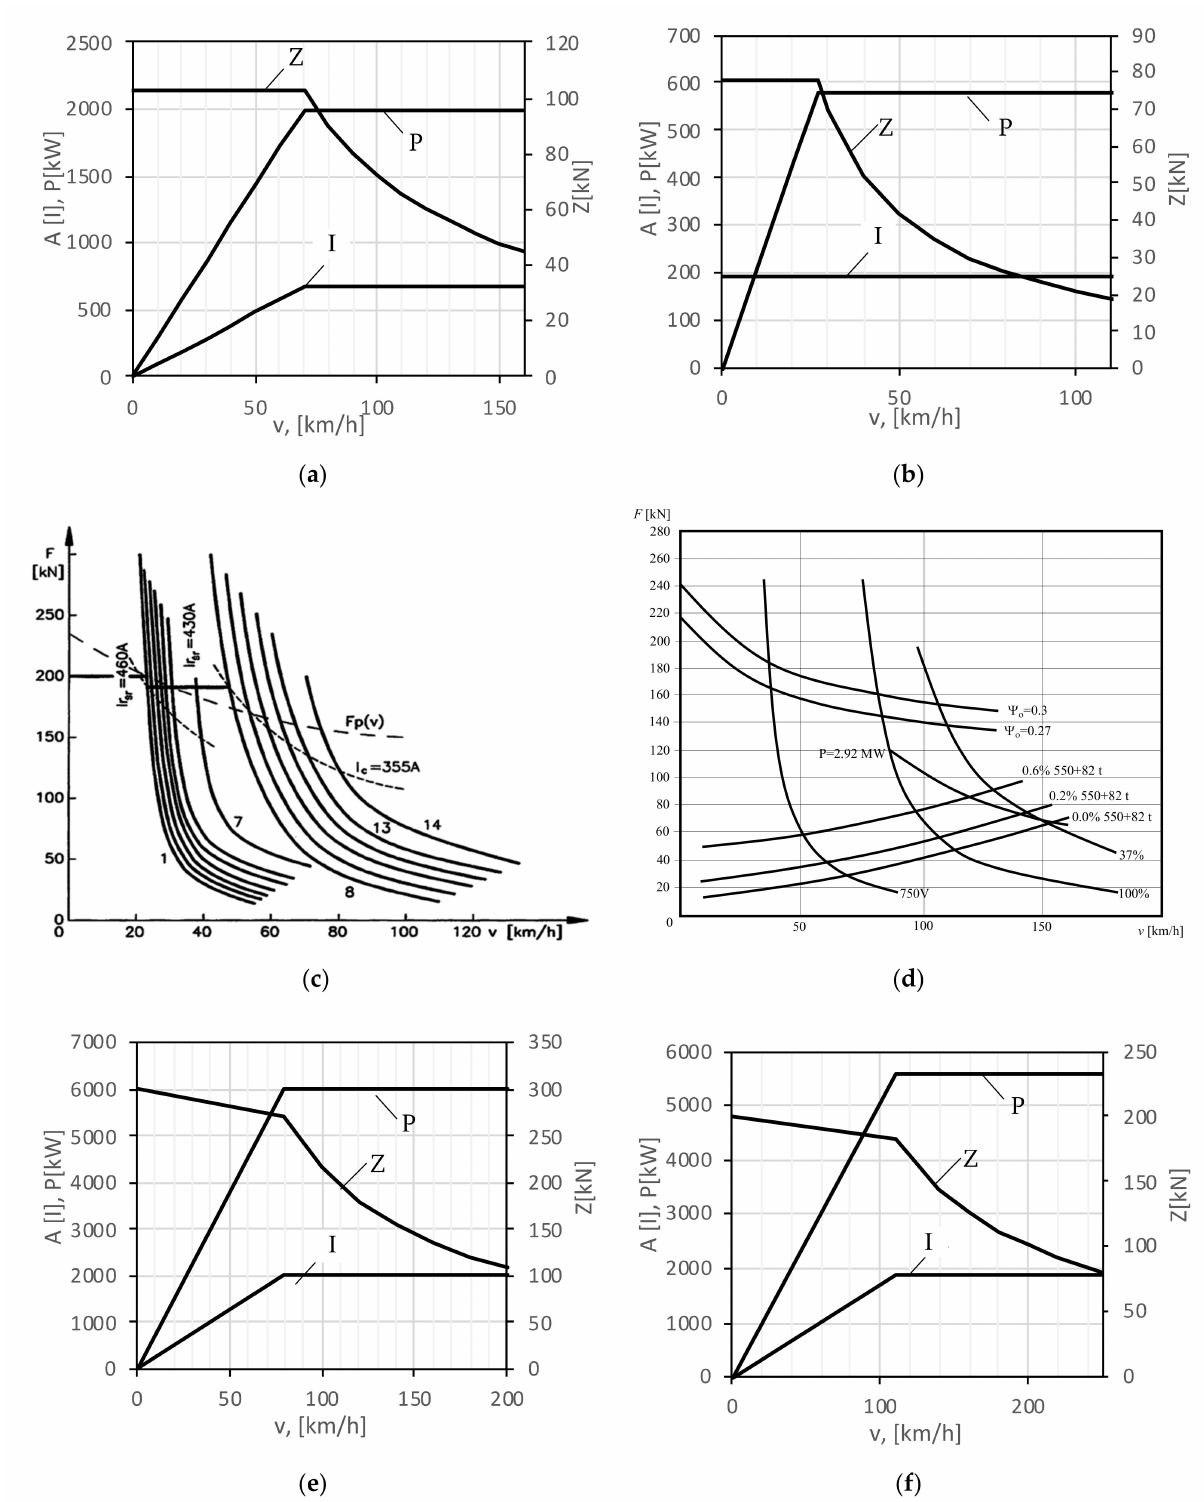
Figure 3. Traction characteristics of trains. Tractive effort (F(v) or Z(v)), power P(v), and electric current consumption I(A): ( a ) Electric multiple unit 31WE “Newag Impuls”; ( b ) electric multiple unit EN57 (simplified) ( c ) EU07 locomotive [61]; ( d ) EP09 locomotive [6]; ( e ) EU44 locomotive ‘Siemens EuroSprinter’ [59]; ( f ) Electric multiple unit ED250 ‘Pendolino’ [6]. The fastest passenger trains of the highest-quality category are operated with ED250 electric multiple units produced by Alstom, Saint-Ouen-sur-Seine